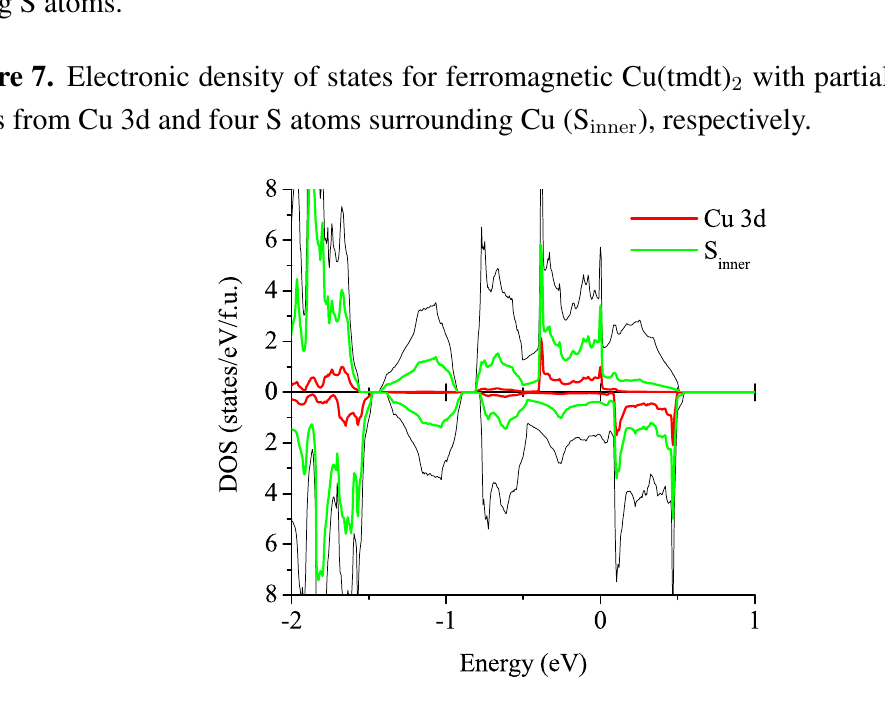
Figure 7. Electronic density of states for ferromagnetic Cu(tmdt) states from Cu 3d and four S atoms surrounding Cu (S